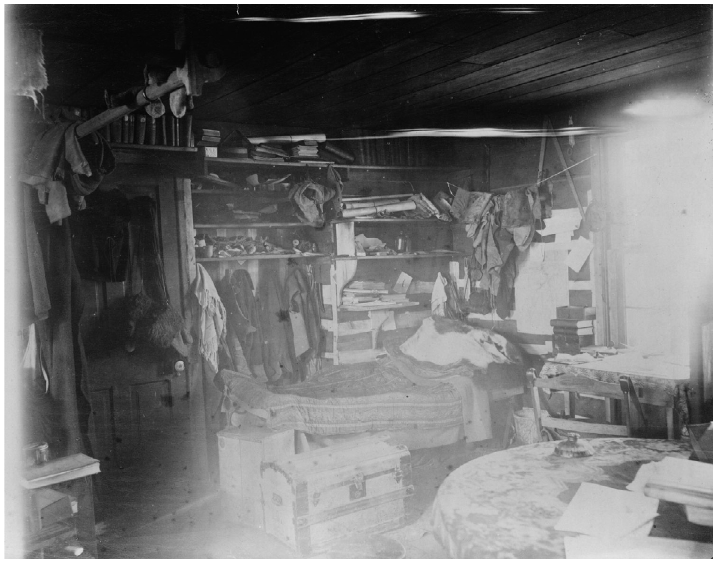
Figure 18. Historic photograph of Lt. James Booth Lockwood’s quarters.